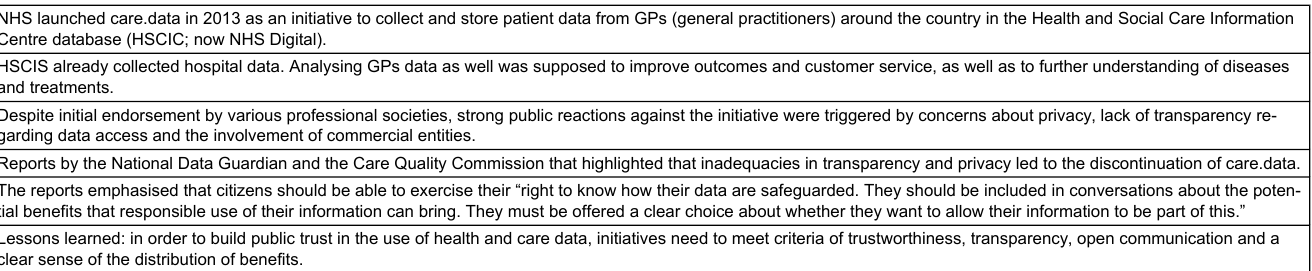
Table 2: Case study overview: care.data National Health Service (NHS) England [53, 54]. NHS launched care.data in 2013 as an initiative to collect and store patient data from GPs (general practitioners) around the country in the Health and Social Care Information Centre database (HSCIC; now NHS Digital). HSCIS already collected hospital data. Analysing GPs data as well was supposed to improve outcomes and customer service, as well as to further understanding of diseases and treatments. Despite initial endorsement by various professional societies, strong public reactions against the initiative were triggered by concerns about privacy, lack of transparency re- garding data access and the involvement of commercial entities. Reports by the National Data Guardian and the Care Quality Commission that highlighted that inadequacies in transparency and privacy led to the discontinuation of care.data. The reports emphasised that citizens should be able to exercise their “right to know how their data are safeguarded. They should be included in conversations about the poten- tial benefits that responsible use of their information can bring. They must be offered a clear choice about whether they want to allow their information to be part of this.” Lessons learned: in order to build public trust in the use of health and care data, initiatives need to meet criteria of trustworthiness, transparency, open communication and a clear sense of the distribution of